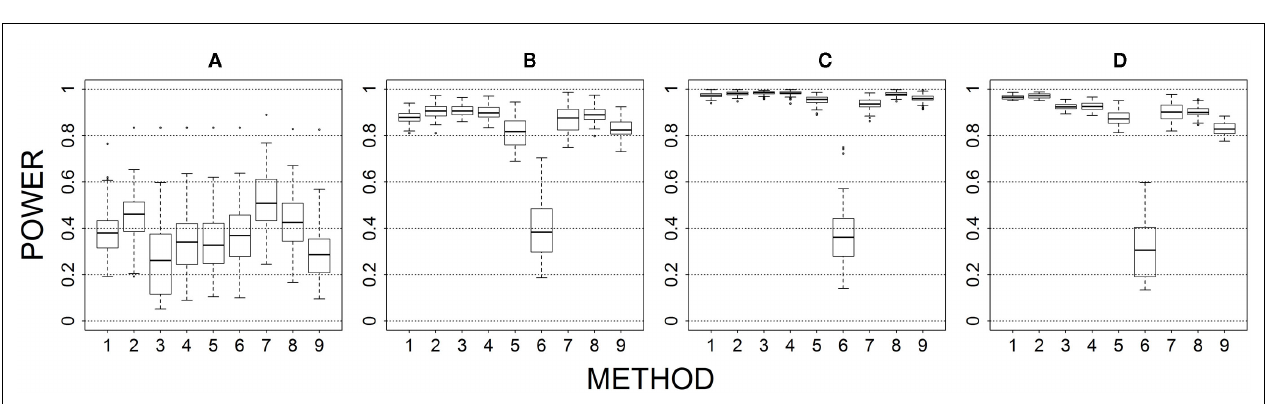
marker-combinations belonging to each average functional allele frequency [ (A) is 0–0.02, (B) is 0.04–0.06, (C) is 0.08–0.11, (D) is 0.13–0.15] and percent-signal category; 1 = CMC01, 2 = CMC05, 3 = SimReg0, 4 = SimReg3, 5 = SimReg4, 6 = SKATsr, 7 = VT, 8 = 2Stage, 9 =